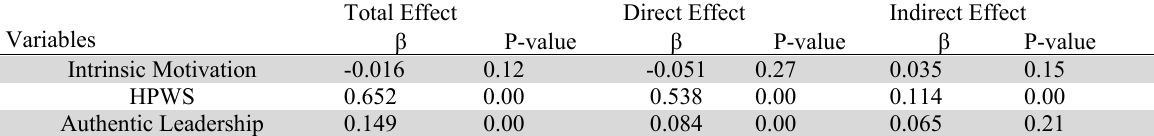
The summary of the direct and indirect effects